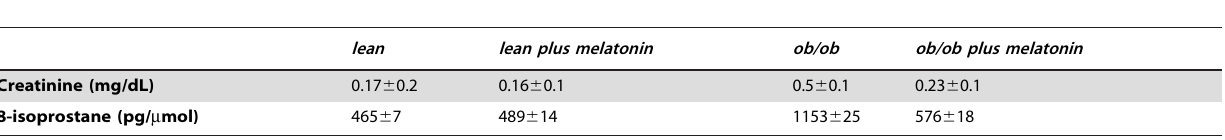
Table 2. Creatinine and renal oxidative